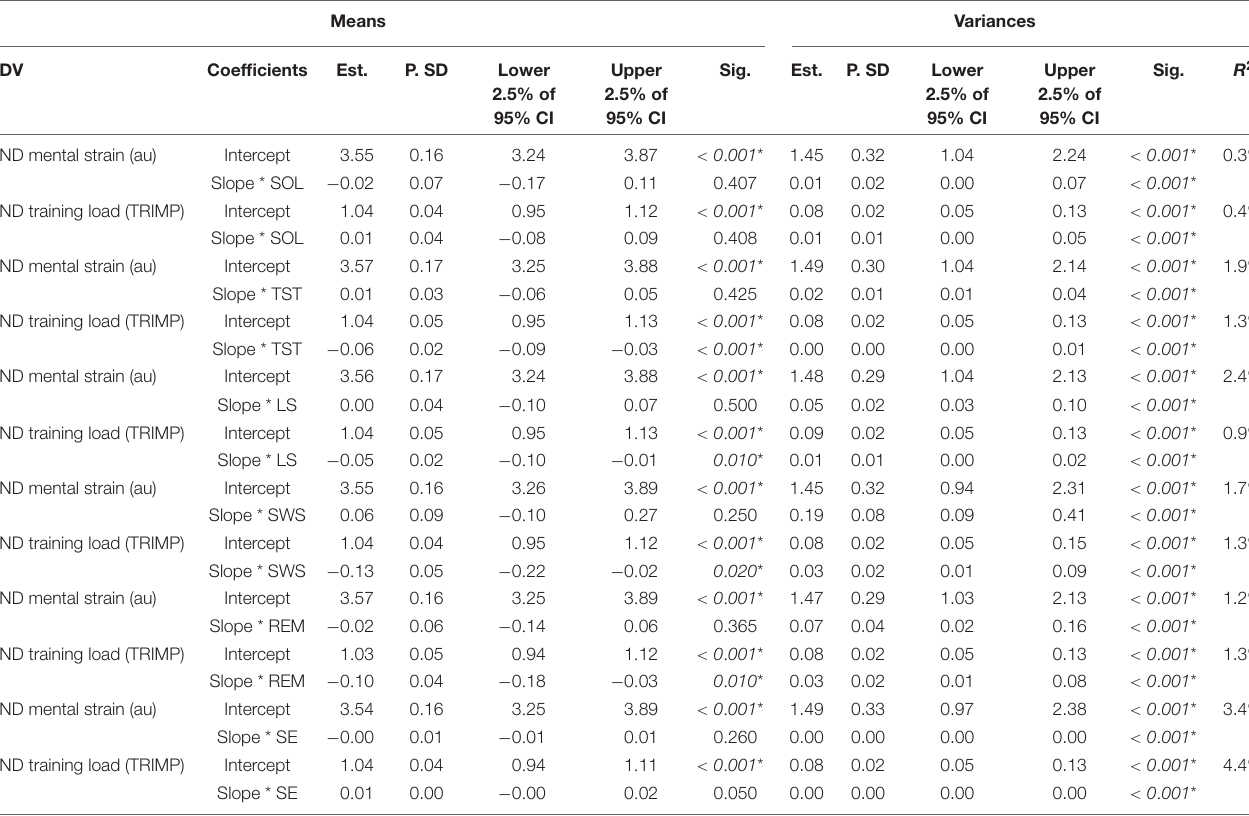
TABLE 5 | Two-level random intercept and random slope models investigating the effect of sleep variables (IVs) on mental strain and training load (DVs) and whether these effects vary between individuals in 56 junior endurance athletes. Means